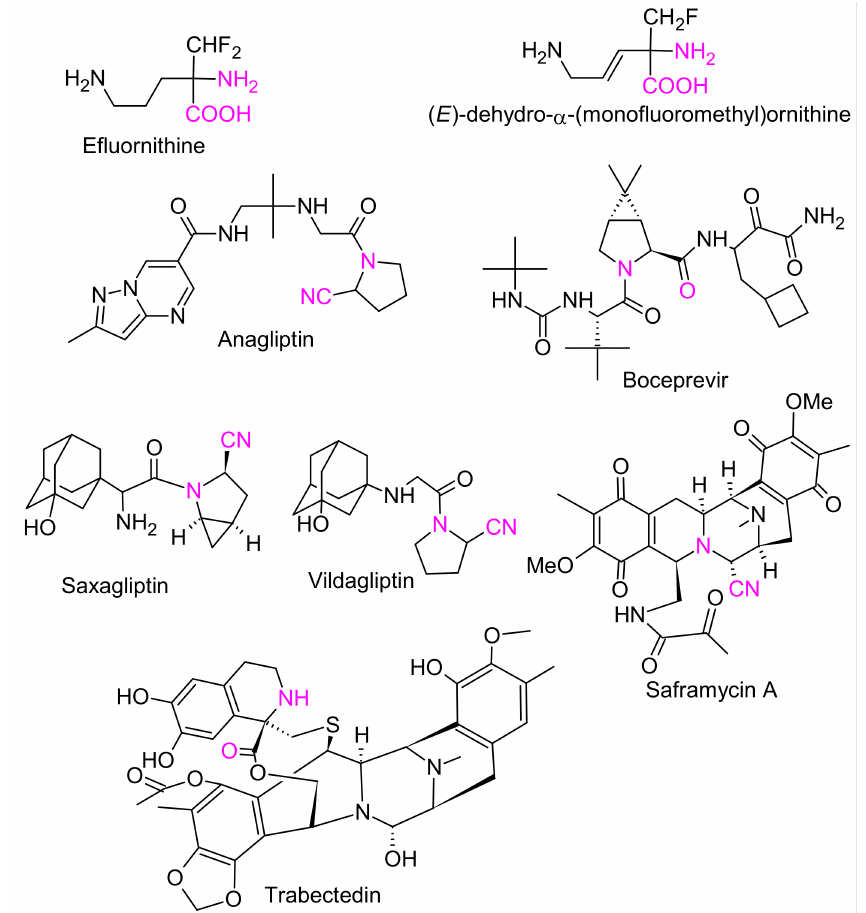
Figure 1. Examples of bioactive amino acids prepared by the Strecker synthesis. Purple colour shows the amino nitrile functions obtained as a result of a direct Strecker